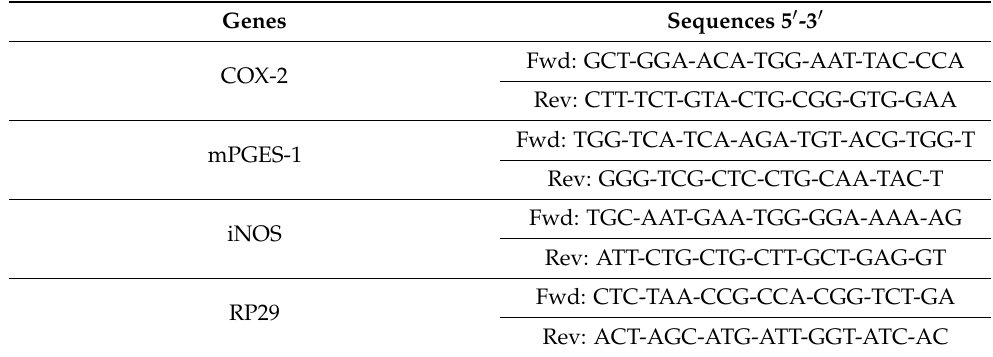
Table 2. Sequences of specific primers for RT-PCR